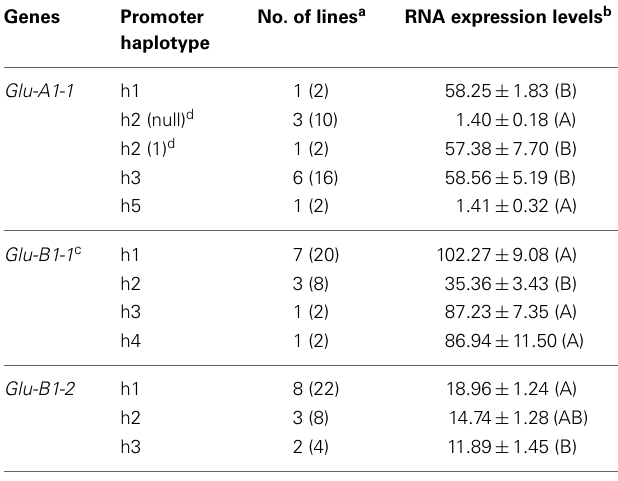
Table 5 | Multiple comparison of the mean levels of RNA expression from promoter alleles of HMW-GS genes at 400 ◦ C days after